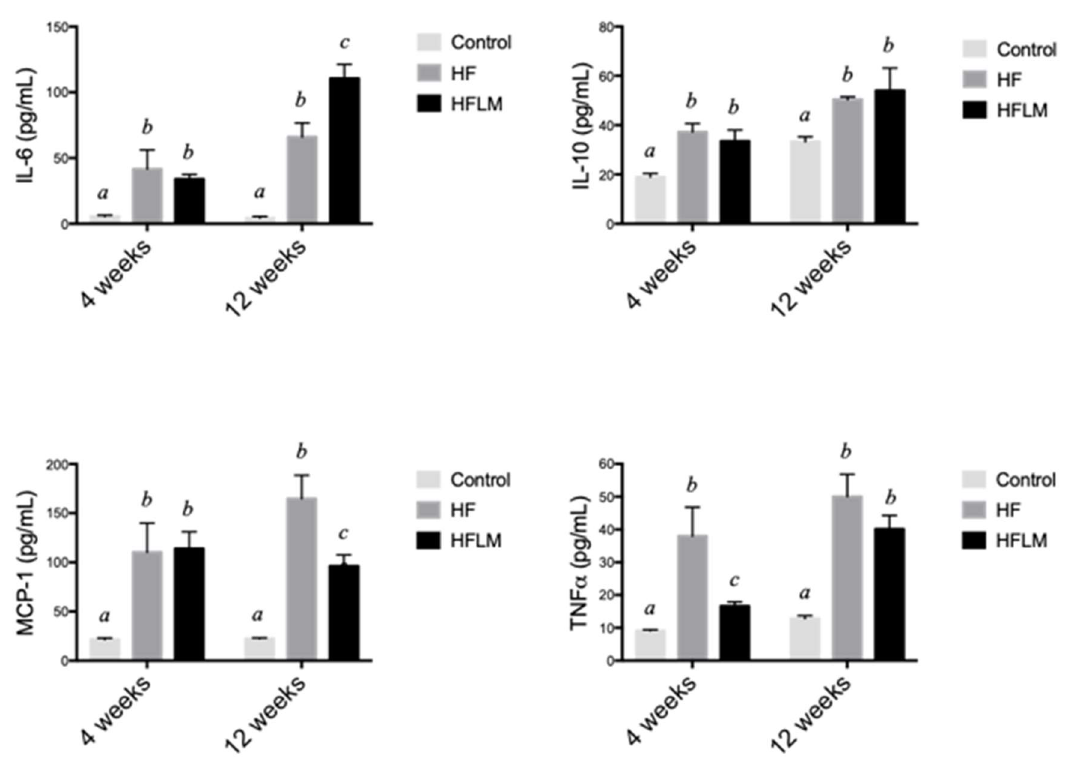
Figure 4. Systemic concentrations of interleukin 6 (IL-6), interleukin 10 (IL-10), monocyte chemoattractant protein 1 (MCP1) and tumor necrosis factor α (TNF- α ) in mice fed- low in methyl donors (HFLM) diet, High-Fat (HF) diet or control diet during 16 weeks (study A). Results are mean ± SEM ( n = 4 per group). Data not sharing superscript letters differ by p < 0.05.